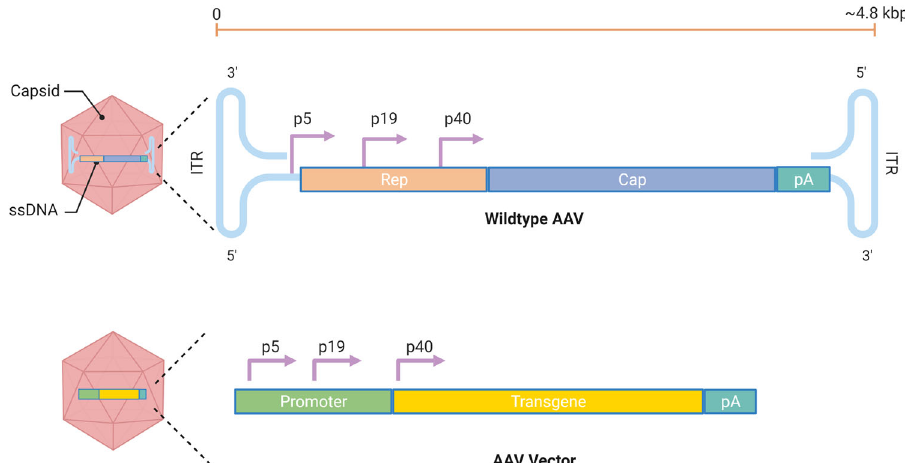
Fig. 2 Schematic representation of the AAV genome and an AAV vector. AAVs are small (~25 nm), non-enveloped viruses and have a 4.8-kb, single-stranded, linear DNA (ssDNA) genome encoding four open reading frames: rep encodes the four genes required for genome replication (Rep78, Rep68, Rep52, and Rep40), cap encodes the structural proteins of the viral capsid (VP1, VP2, and VP3). When the viral vector is used in vaccinations, the transgene of choice is placed in the promoter at the p40 location.